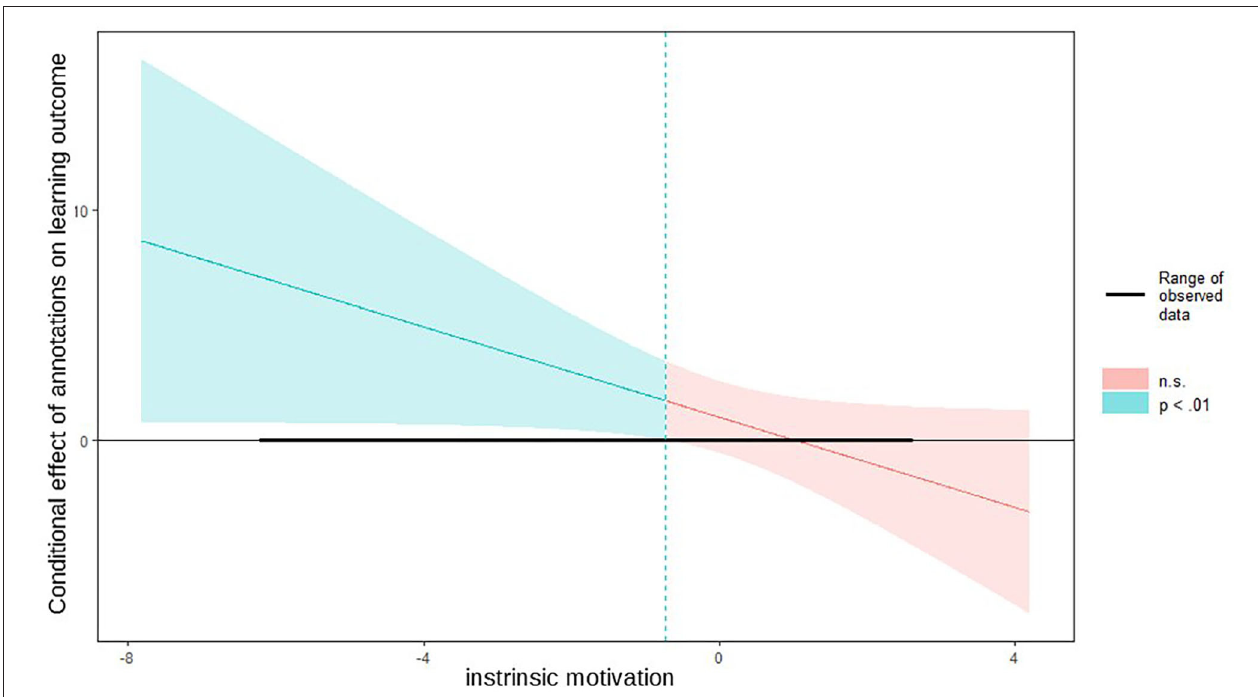
FIGURE 4 | Johnson-Neyman interval for intrinsic motivation moderating the relationship between the treatment factor annotations and learning outcome.